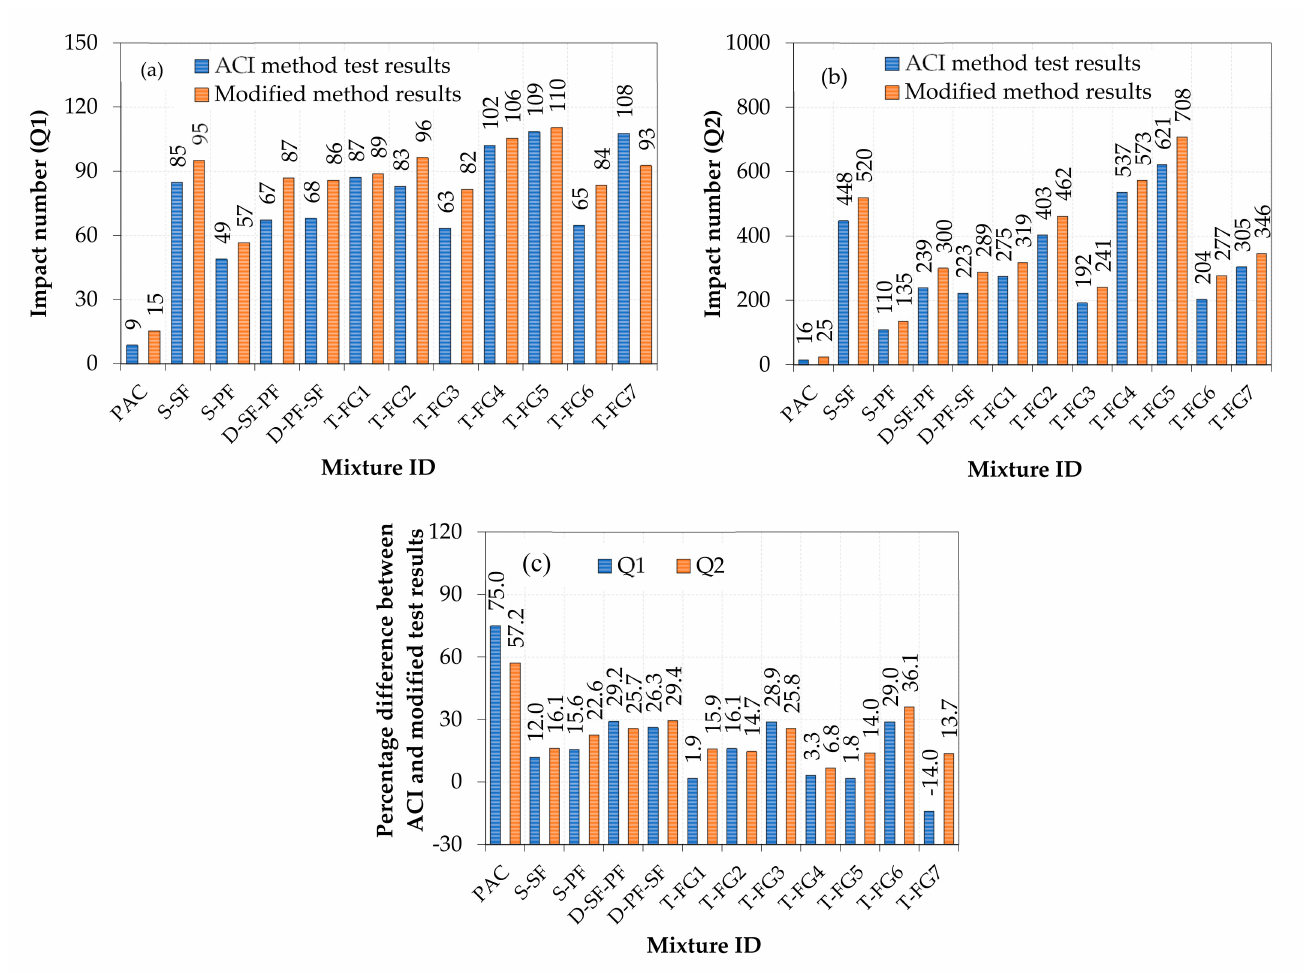
Figure 15. Results of ACI and a modified technique comparison, ( a ) Q1, ( b ) Q2, ( c ) Percentage difference ACI and modified test